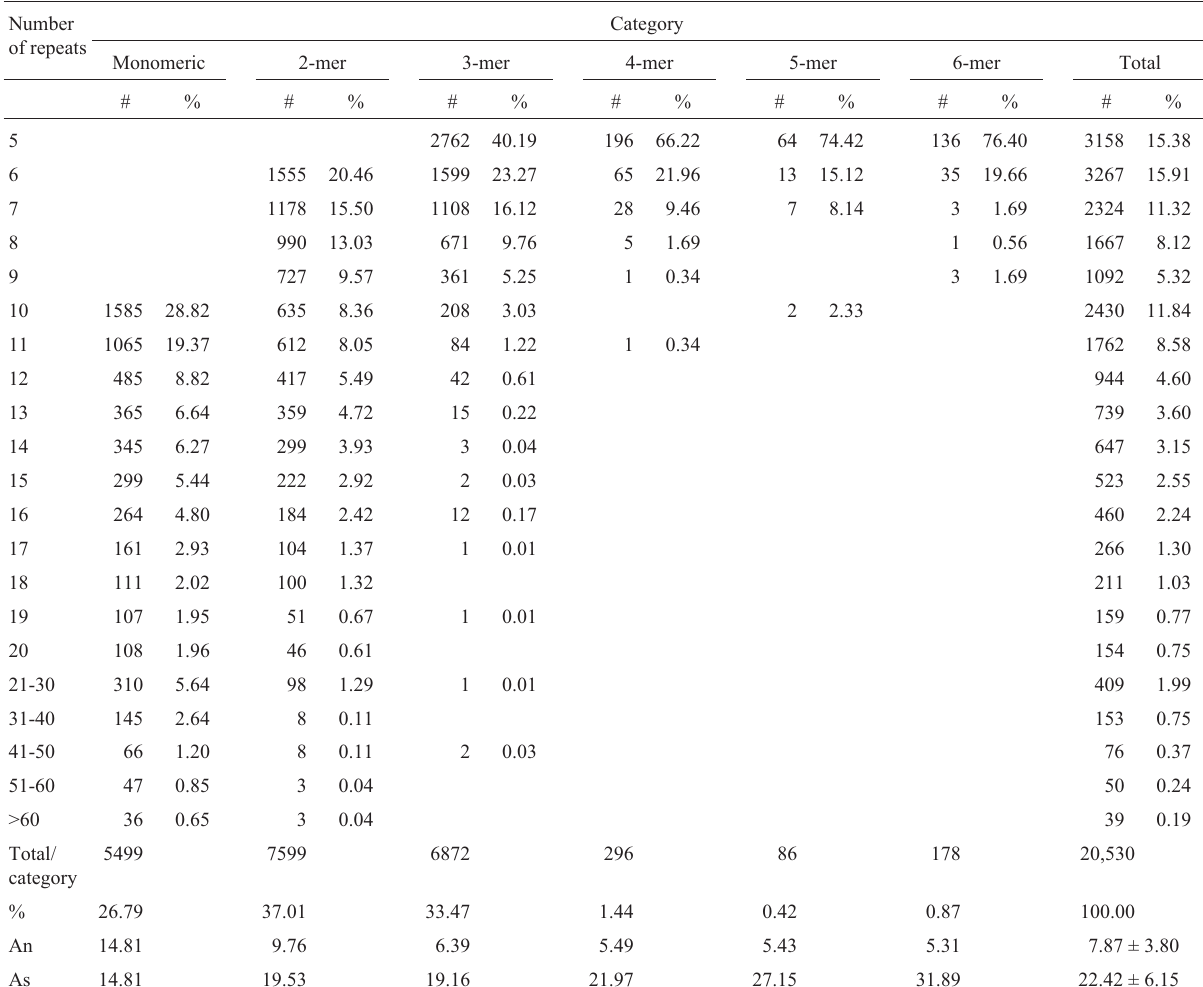
Table 2 - Occurrence of individual motif categories among the set of 20,530 microsatellites from the total Eucalyptus EST FORESTs database*. Number of